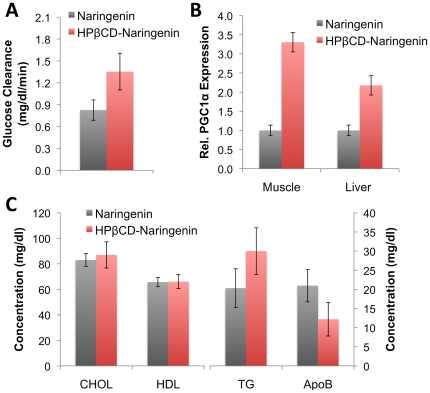
HPβCD-naringenin complex ameliorates the effects of a fat and glucose-rich meal.(a) Male Sprague-Dawley rats were fasted overnight, and then fed 20 mg/kg body weight naringenin either alone or as a HPβCD-naringenin complex. 30 min later, the rats were administered a meal composed of a suspension of 1 ml/kg olive oil and 1 g/kg glucose. Glucose clearance was measured as the rate of return to normal from maximal concentration (about 65 min). (b) Plasma cholesterol, HDL, triglycerides, and ApoB100 (VLDL) were measured 3.5 hrs after the meal. Cholesterol and HDL levels did not change. Triglyceride levels in rats fed the HPβCD-naringenin complex were elevated, but not significantly (p = 0.24, n = 3). In contrast, plasma levels of ApoB100, the structural protein of VLDL, were significantly 42% lower (p = 0.05, n = 3) than rats given naringenin alone. (c) mRNA abundance of PGC1α increased by 230±100% and 118±60% in skeletal muscle and liver, respectively. Tissue samples were collected 3.5 hrs after the meal.